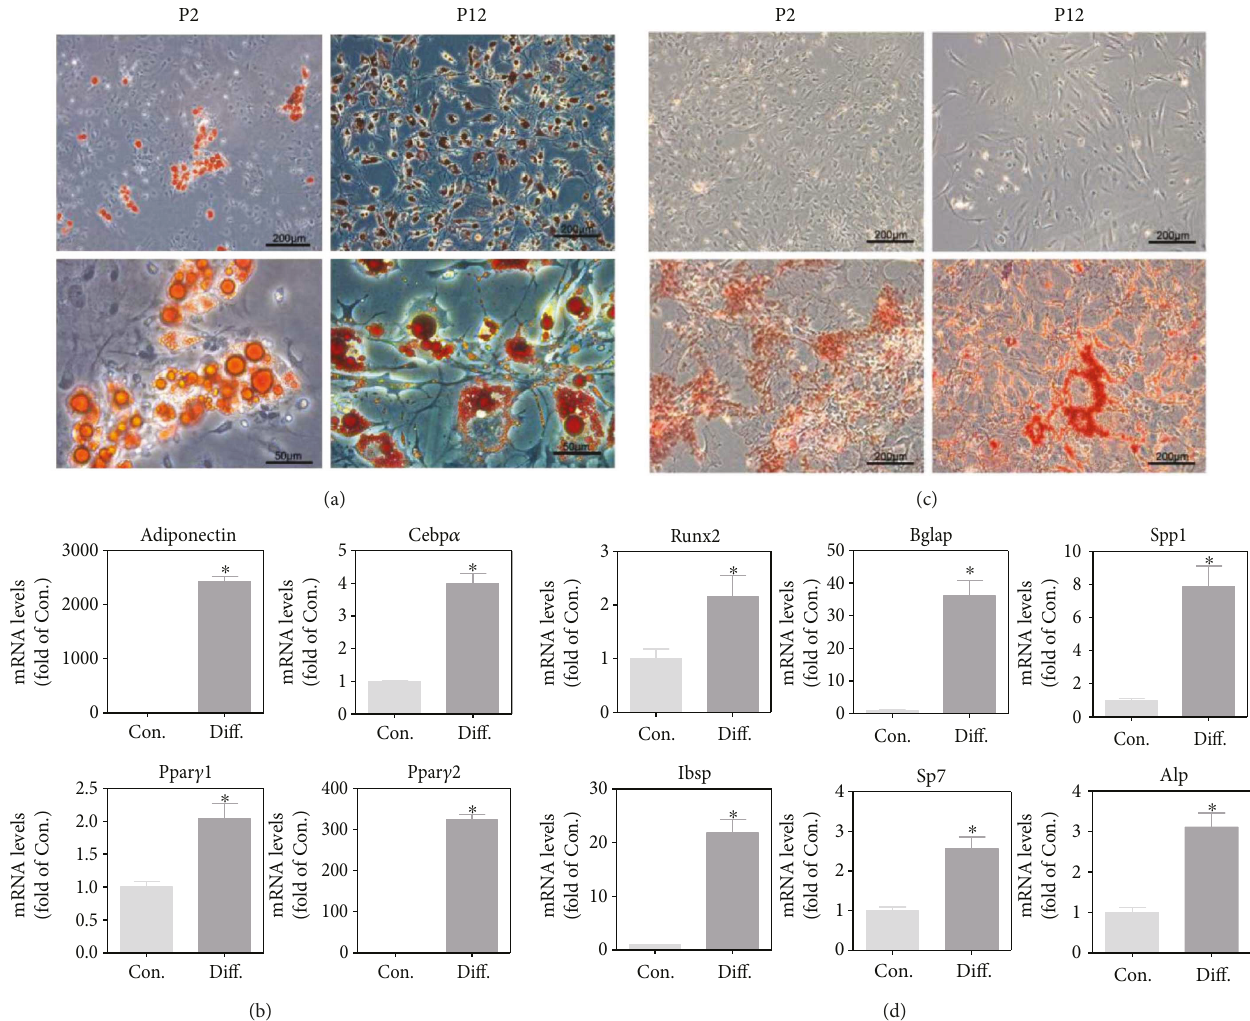
Figure 6: Adipogenic di ff erentiation and osteogenetic di ff erentiation at the earlier passage and the later passage of BM-MSCs cultured in 5% oxygen condition. (a) Representative images for Oil Red O staining at P2 and P12 (from upper to lower, × 100 with scale bar =200 μ m, × 400 with scale bar =50 μ m). (b) The expression of adipogenic di ff erentiation-related genes of BM-MSCs at P12 in BM-MSCs cultured in BM-MSC medium (Con.) and adipogenic induction medium (Di ff .). (c) Representative images for Alizarin Red S staining at P2 and P12 ( × 100 with scale bar =200 μ m, from upper to lower: cultured in BM-MSC medium, and cultured in osteogenetic induction medium). (d) The expression of osteogenetic di ff erentiation-related genes at P12 in BM-MSCs cultured in BM-MSC medium (Con.) and osteogenetic induction medium (Di ff .). Results are expressed as mean ± SD from three independent measurements. ∗ p < 0 05 versus Con.